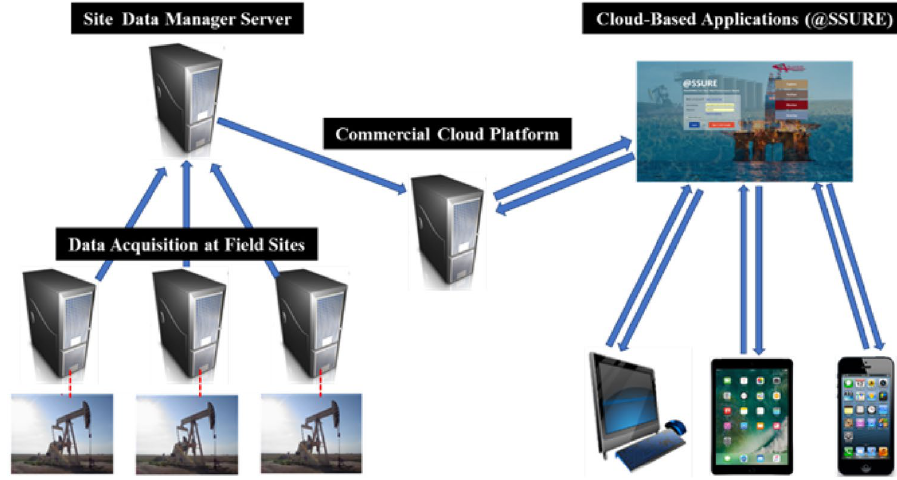
Fig. 1 Data collection, transmission, storage, access, display, and analysis model for remote real-time monitor- ing applied to Karnes injection